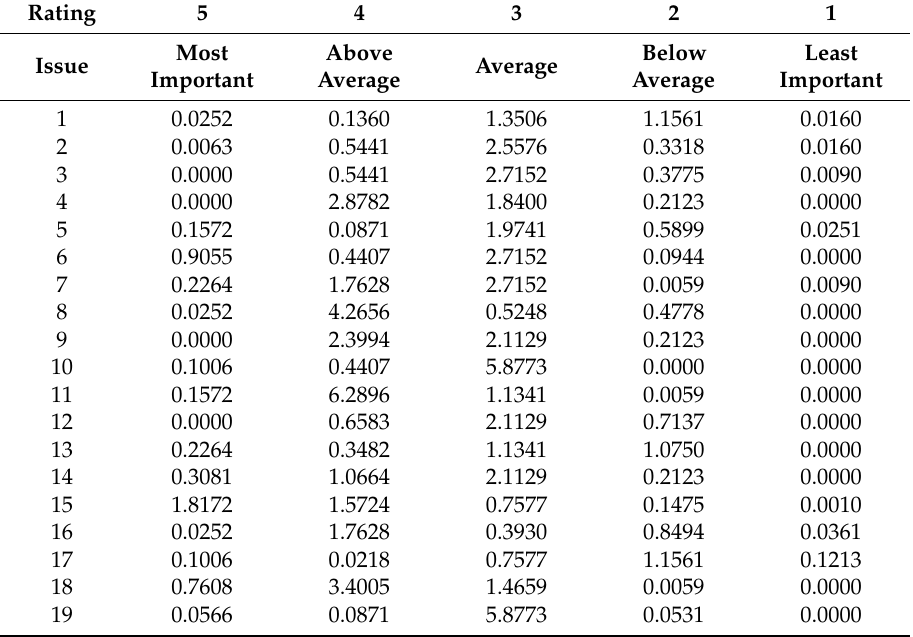
Table 21. Weighted Matrix of Normalized Data.